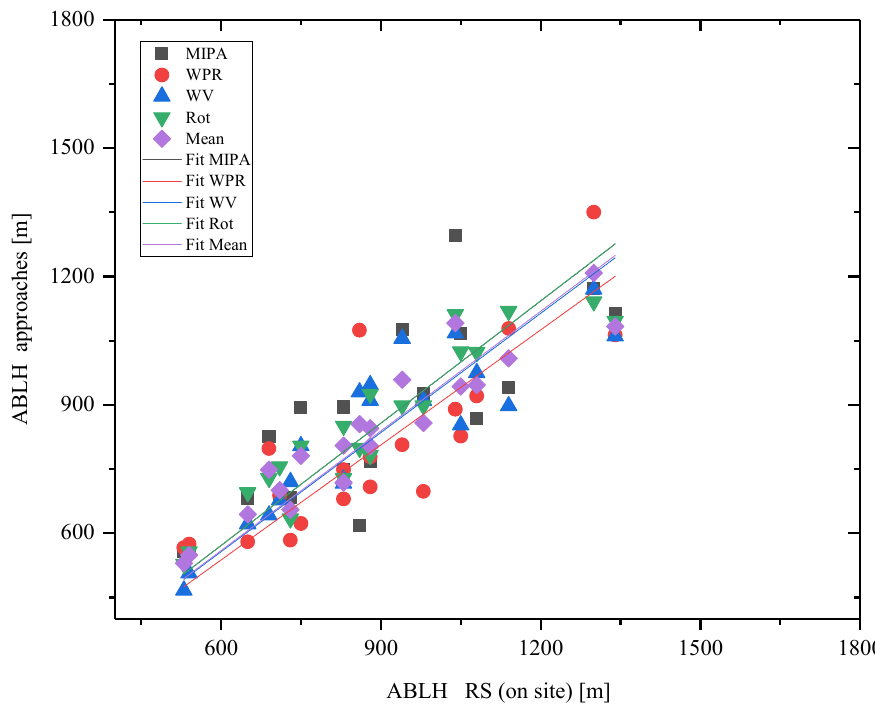
Figure 4. Comparison of different ABLH estimates expressed in terms of linear fitting for each approach. The x -axis shows the ABLH reference values obtained by applying the potential temperature approach to in-situ radiosondes, while the y -axis refers to the estimates provided by the compared approaches.